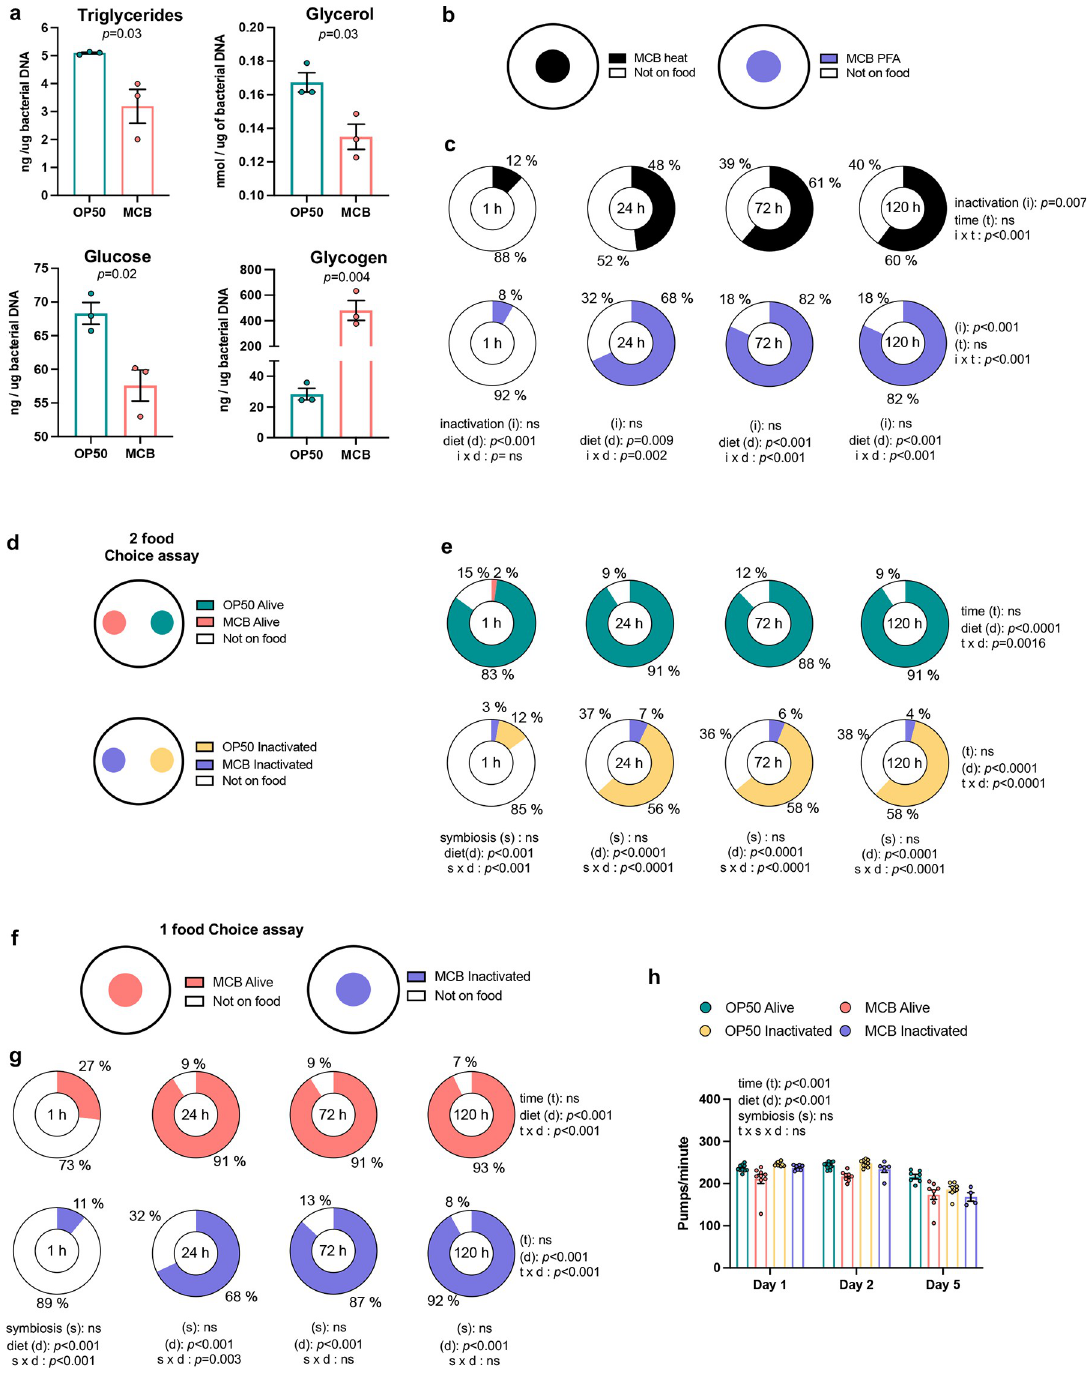
Fig 3. Bacterial food quality of MCB and C . elegans food intake and preferences. ( a) Concentrations of triglycerides, glycerol, glucose and glycogen in E . coli OP50 and in MCB homogenates described in Fig 2, as determined based on similar DNA content. Each bar represents the average of three measurements performed in technical duplicates. (b) Schematic illustration of food preference assay between heat-inactivated versus PFA-inactivated microbiota. ( c) Percentage of adult worms on and off the bacterial lawn. n = 40 worms/ replicate for a total of 120 worms. ( d) Schematic illustration of food choice assay between two different bacteria. ( e) Percentage of adult worms on and off of the bacterial lawns. n = 40/replicate for a total of 240 worms. ( f) Schematic choice assay between alive versus inactivated MCB. ( g) Percentage of adult worms on and off the only one bacterial lawn. n = 40 /replicate for a total of 240 worms. ( h) Pharyngeal pumping per minute of worms fed with E . coli OP50 or MCB either alive or inactivated. Statistical comparisons by 2 x 2 ANOVA. ns: Not